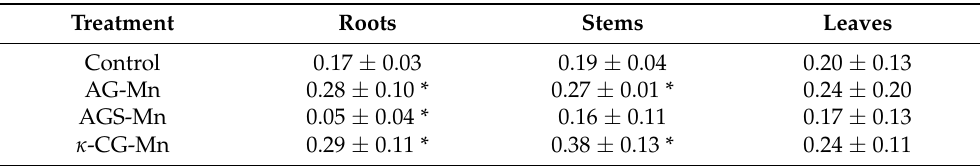
Table 2. The accumulation of Mn (wt% ± SD) in plants grown in the control medium and in a medium with NCs. Treatment Roots Stems Leaves Control 0.17 ± 0.03